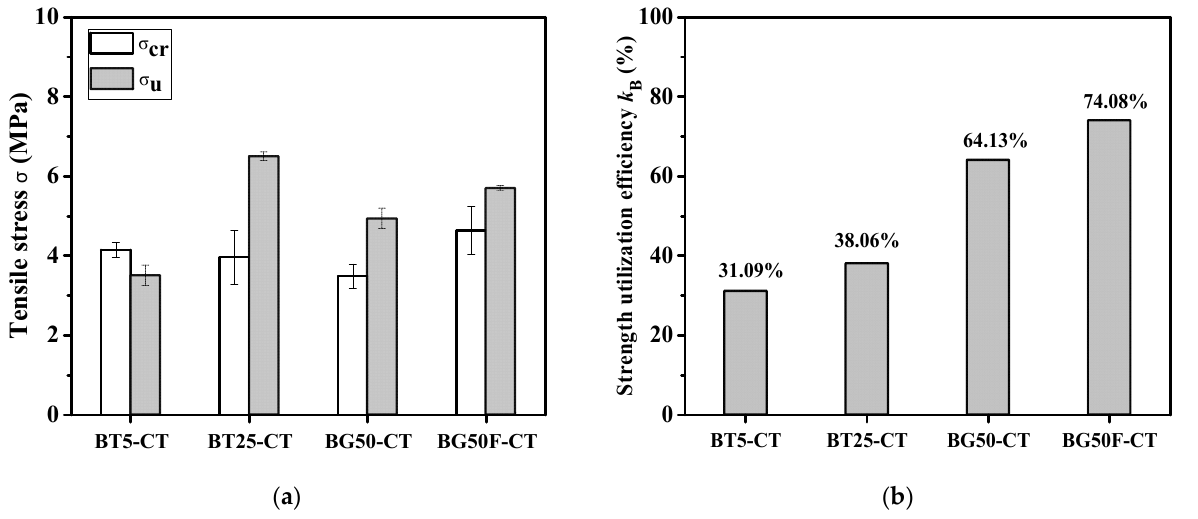
Figure 8. Tensile behaviors of the BGRM before exposure to elevated temperature: ( a ) tensile stress; ( b ) strength utilization efficiency k B .